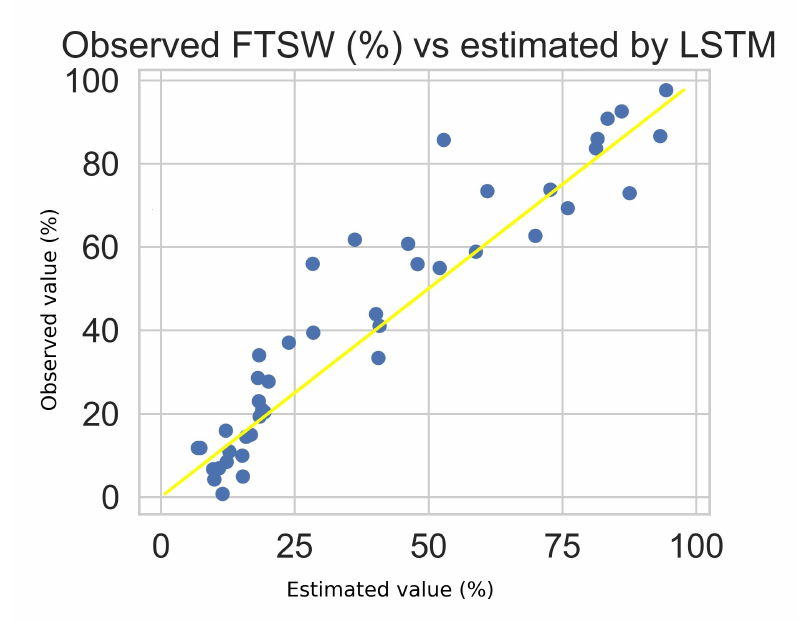
Figure 11. Comparison between observed and predicted values of the FTSW at Quinta de Pancas.